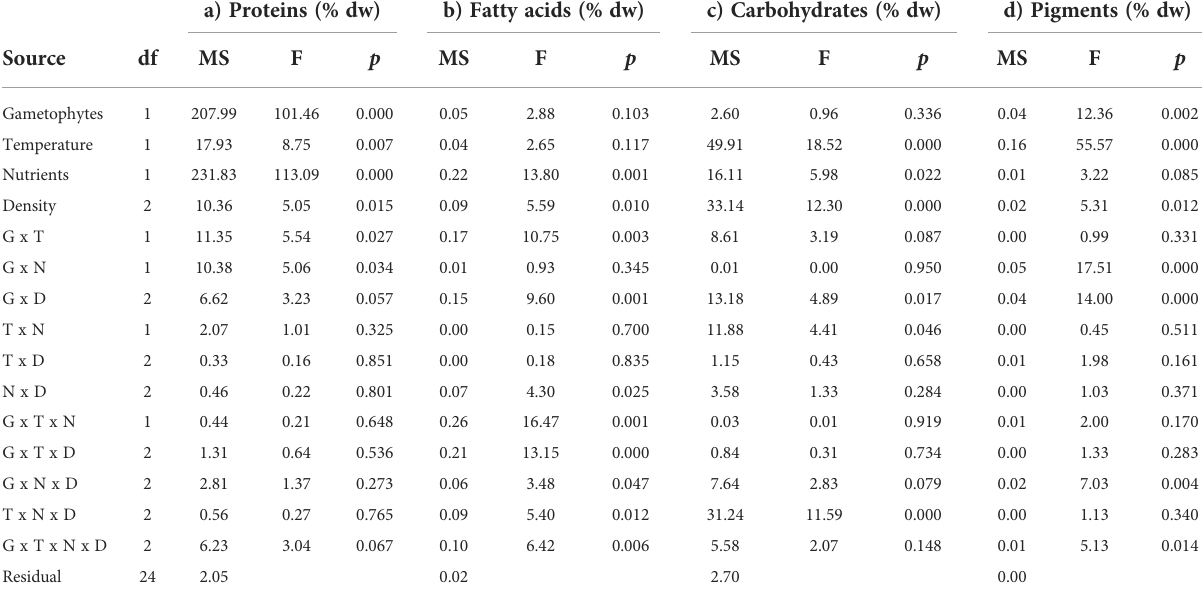
TABLE 2 Analysis of variance of a) total protein (% dw), b) fatty acid (% dw), c) carbohydrate (% dw), and d) pigment content in clonal and recombinant gametophytes (G) exposed to different temperature (T), nutrient concentrations (N) and densities (D) in a 12 week hatchery